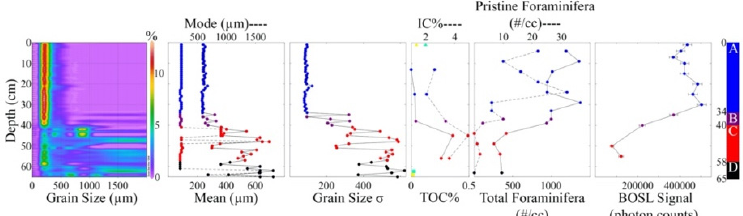
Figure 4. Core LL16 C1 results. Grain size distribution with depth in the core (1 cm sampling resolution) presented as a contour map (Ocean Data View ‘ODV’ Version 5.5.2 (Schlitzer, Reiner, Ocean Data View, https://odv.awi.de, 2021, accessed 1 February 2021)) as well as in conventional profiles (mean, mode, standard deviation). TOC and IC values (%) of a representative set of samples are shown as a profile for Core C1, reference samples are shown in squares (TOC) and triangles (IC) to show their comparative values to the core (yellow = aqueduct beach sand ramp; aquamarine = shallow marine ( − 5 m depth), see Figure 1 for specific locations). Total and pristine foraminiferal abundances are shown plotted by core depth, sampling resolution of 5 cm. B-OSL signals (photon-counts) are plotted by depth with a resolution of about 3–5 cm in units A and B, and 10 cm in Unit C. The far right core illustration provides the thickness of each unit to scale, and the colors of the data points correspond with visually recognizable units.